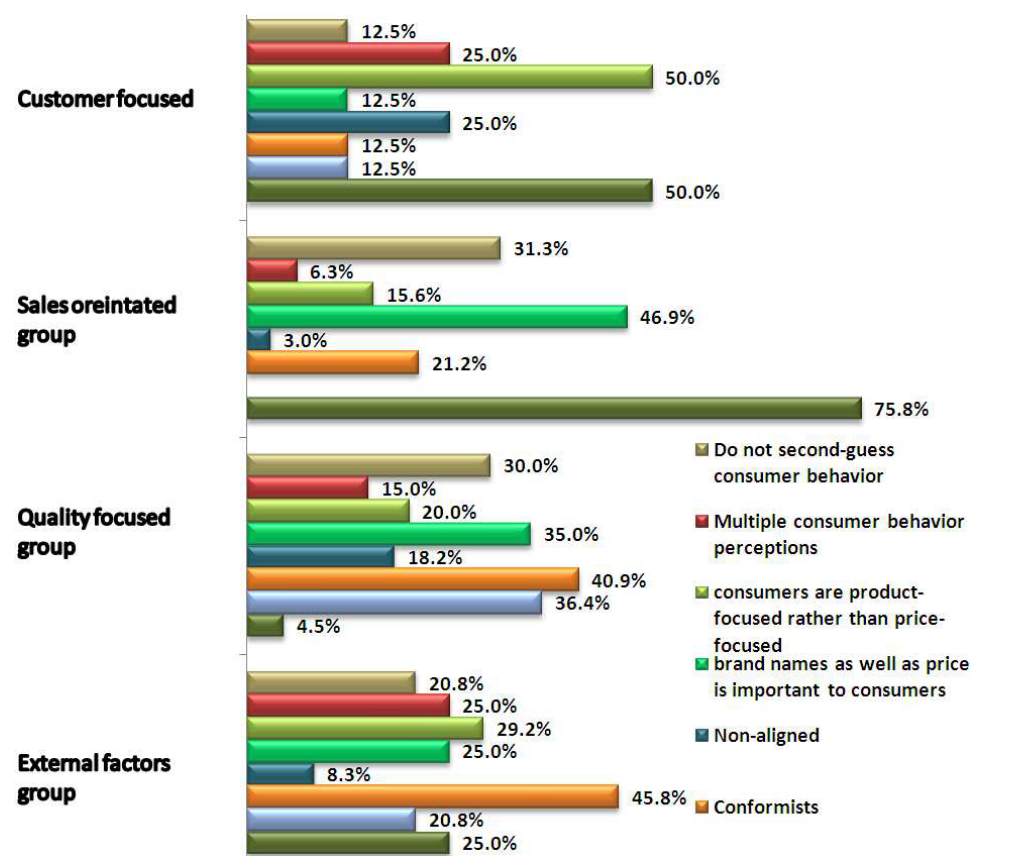
Fig. 1. Strategy tendencies of the different product characteristics